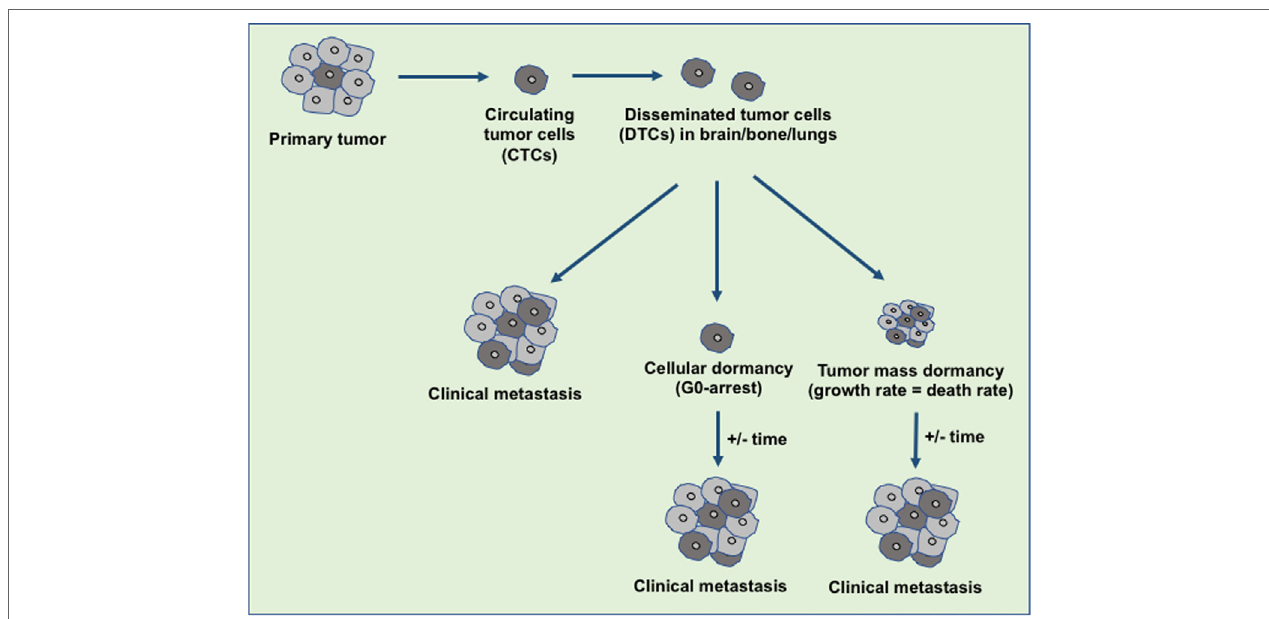
FiGURe 1 | An overview of disseminated tumor cells (DTCs) in dormancy and clinical metastasis relapse. During the metastasis, the disseminated primary tumor cells developed the secondary tumor in the distant organ sites immediately or at a later stage. The tumor microenvironment or the intrinsic factors decide the fate of the DTCs either to develop clinical metastasis or to maintain the dormant state. Over the years, these dormant tumor cells escape from dormancy state and develop the clinical